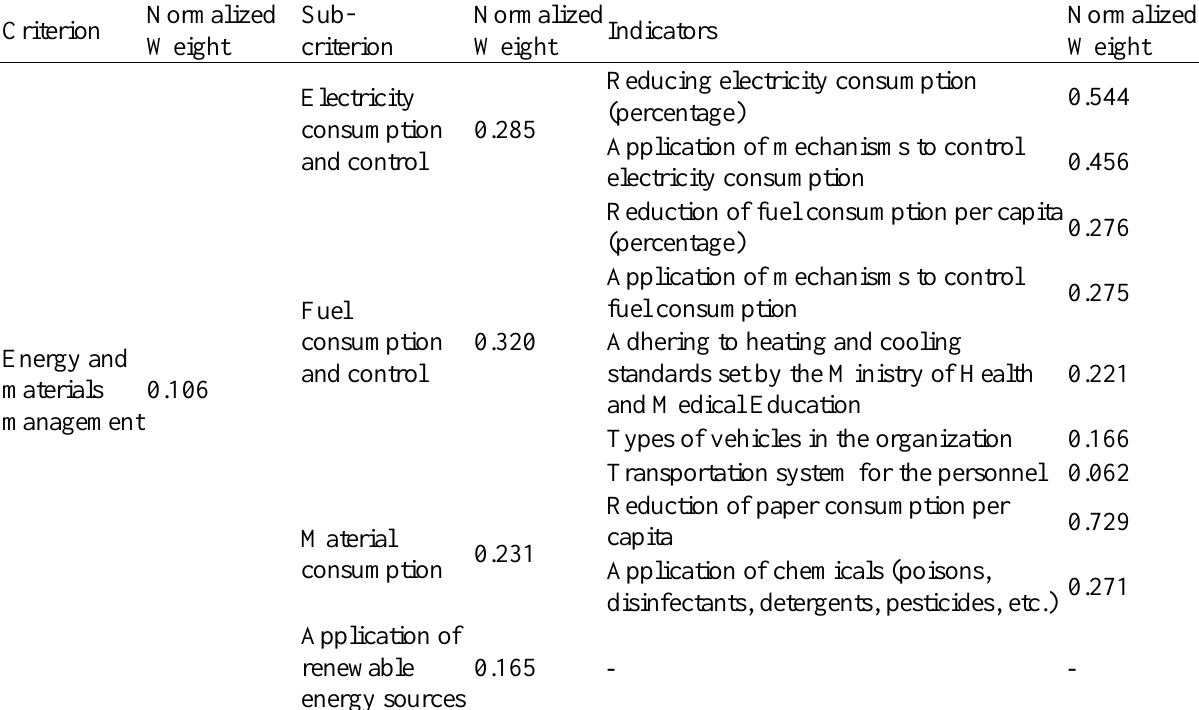
Table 5. Energy management sub-criteria, indicators and corresponding weights